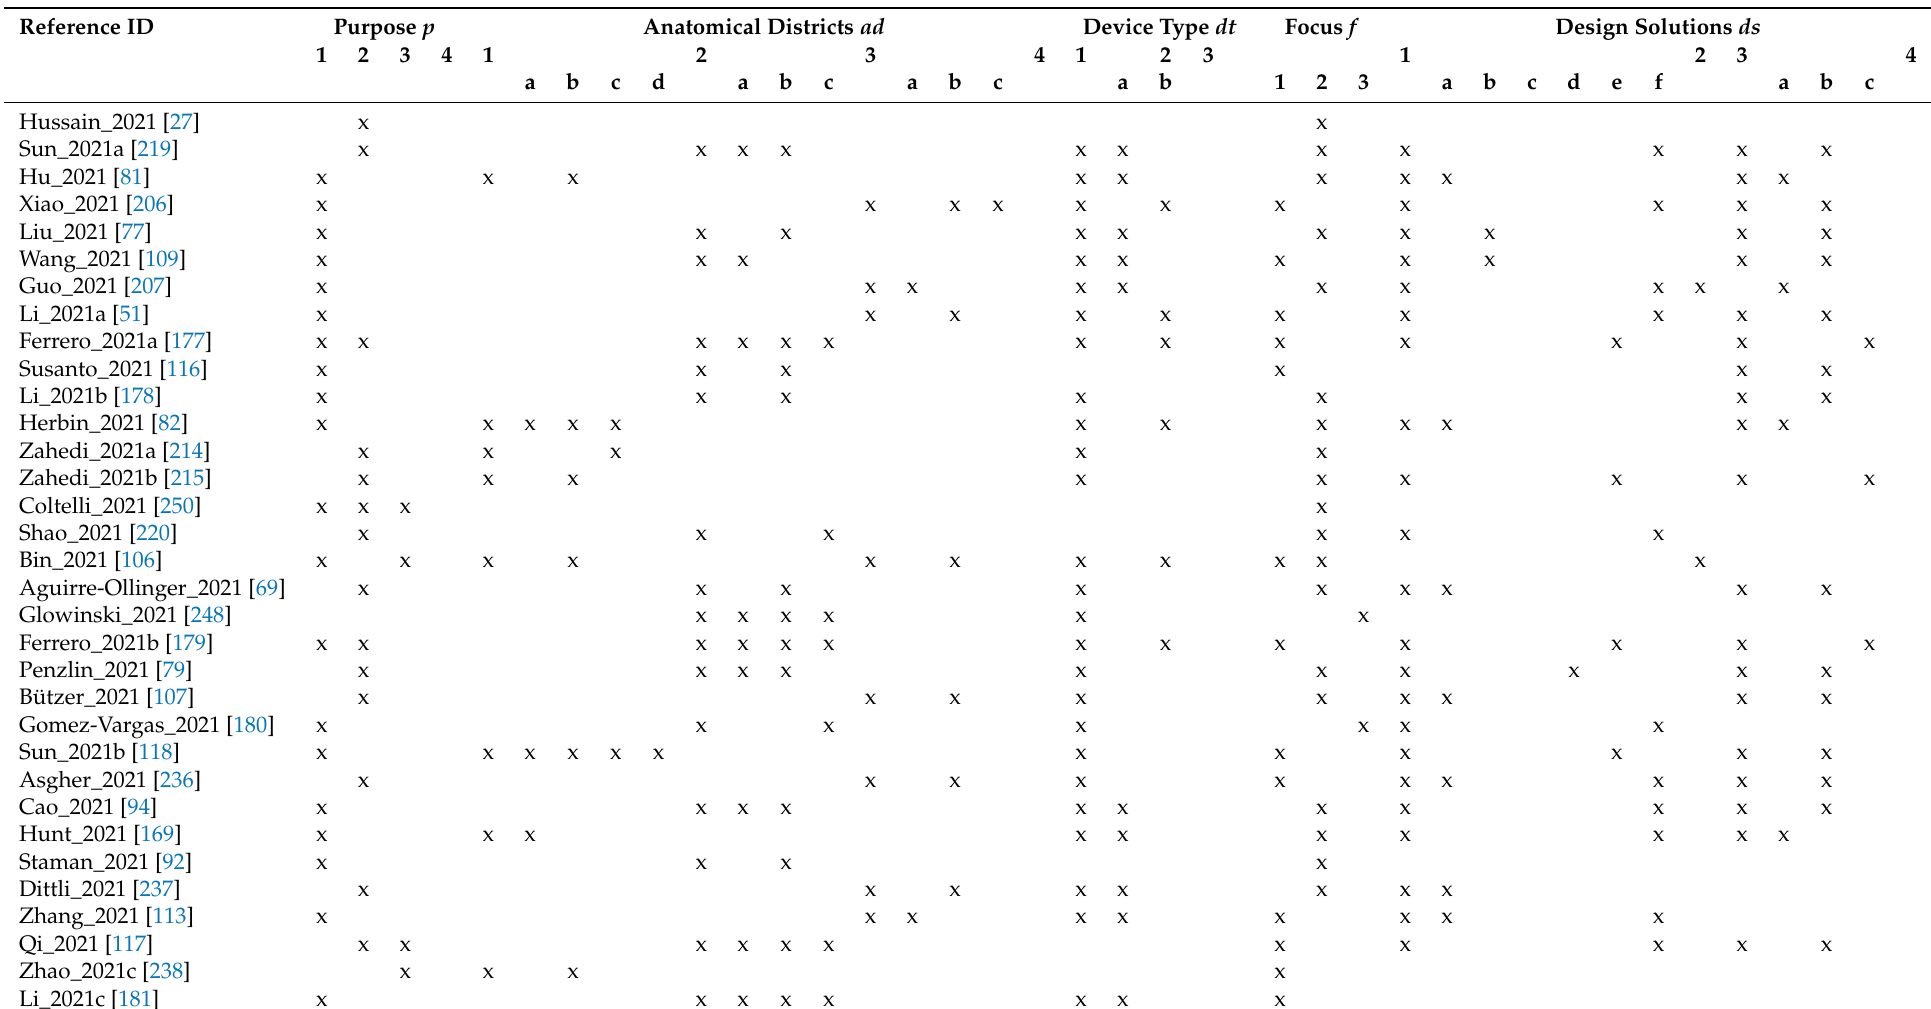
Table A6. Main review publications on Exoskeleton